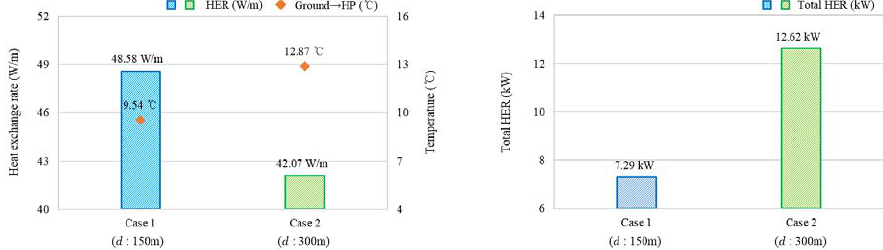
Figure 5. Comparison of the HER in different length of the GHX: Case 1 (GHX: 150 m); and Case 2 (GHX: 300 m). Figure 6 indicates the distribution of underground temperature for Cases 1 and 2.